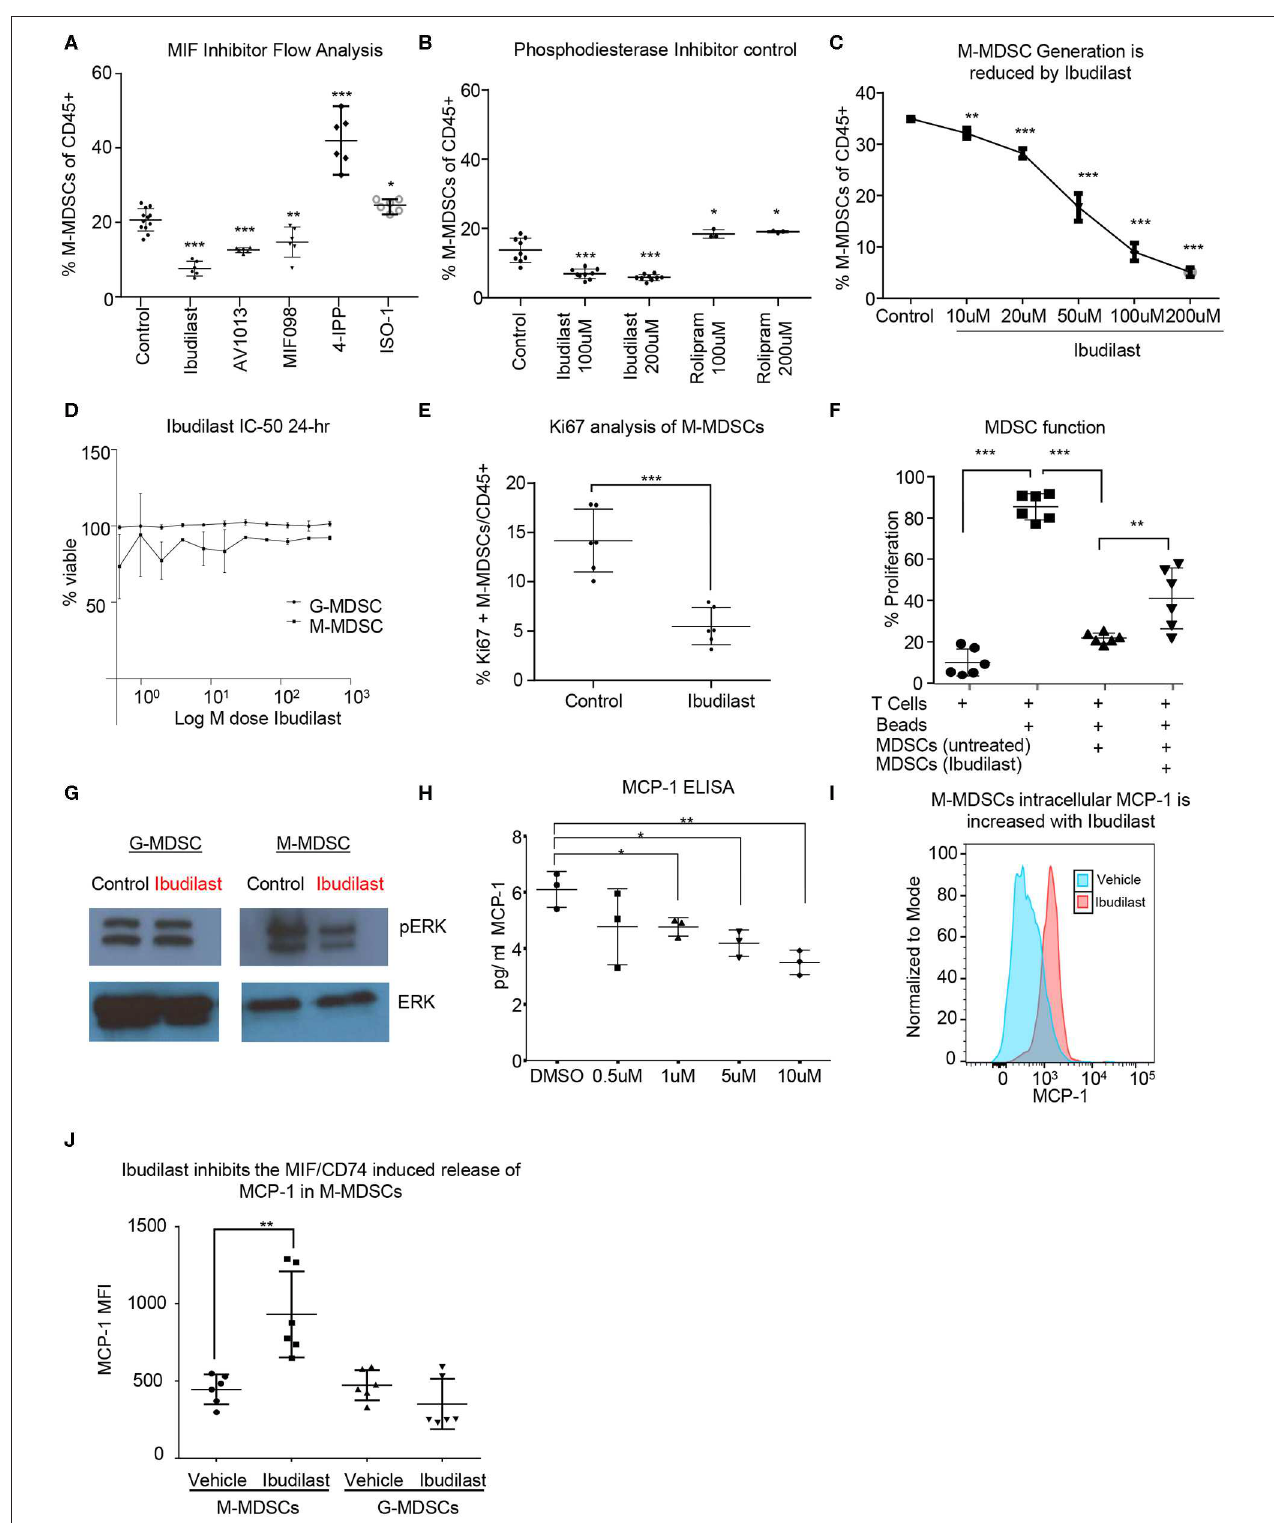
FIGURE 4 | Ibudilast inhibits the MIF disrupting M-MDSC generation in vitro. Utilizing the co-culture system described in Figure 1 MIF inhibitors were assessed for their ability to inhibit MDSC generation (A) . Inhibitors were added at 200 µ M at day 0 during the co-culture initiation and then assessed at day 3 for the %